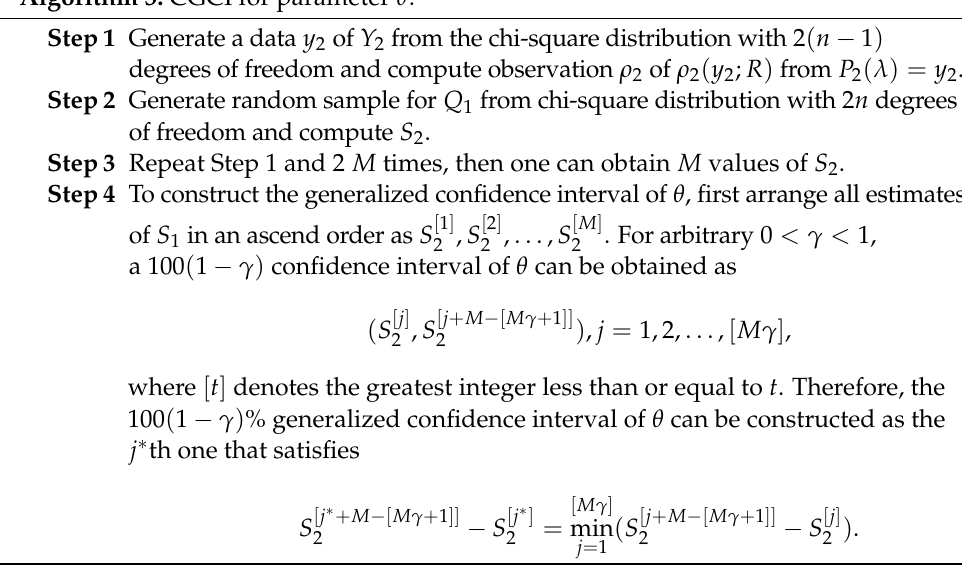
Algorithm 3: CGCI for parameter θ